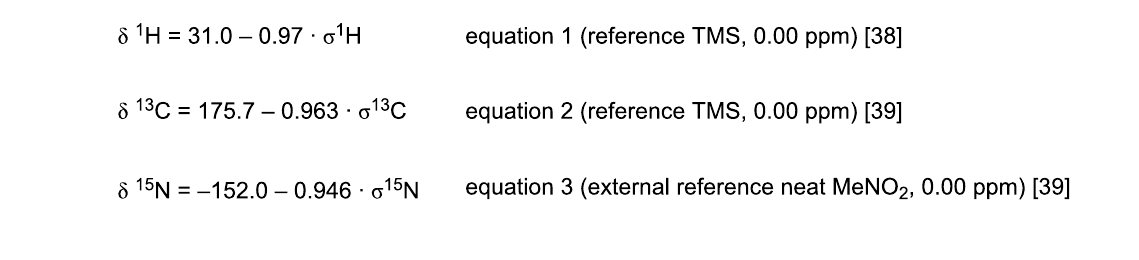
Figure 11: Equations used to transform absolute shieldings into chemical shifts [38,39].